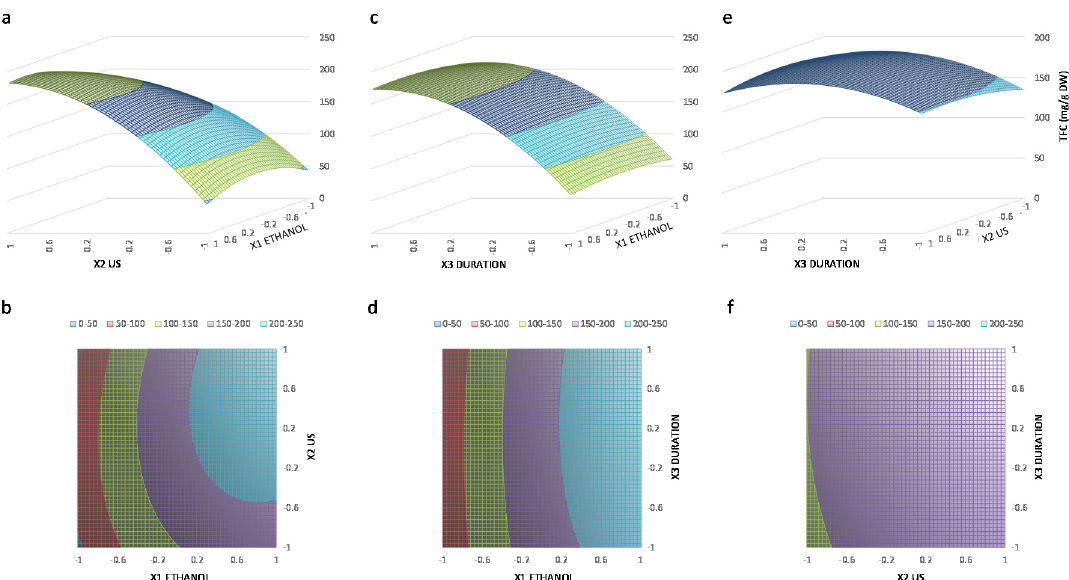
Figure 2. Three-dimensional (3D) surface response and two-dimensional (2D) contour plots, respectively, from the model predicted TFC (in mg/g DW) extracted from mature N. lotus stamens as a function of aqEtOH concentration and US frequency. ( a , b ), aqEtOH concentration and extraction duration ( c , d ) and US frequency and extraction duration ( e , f ).